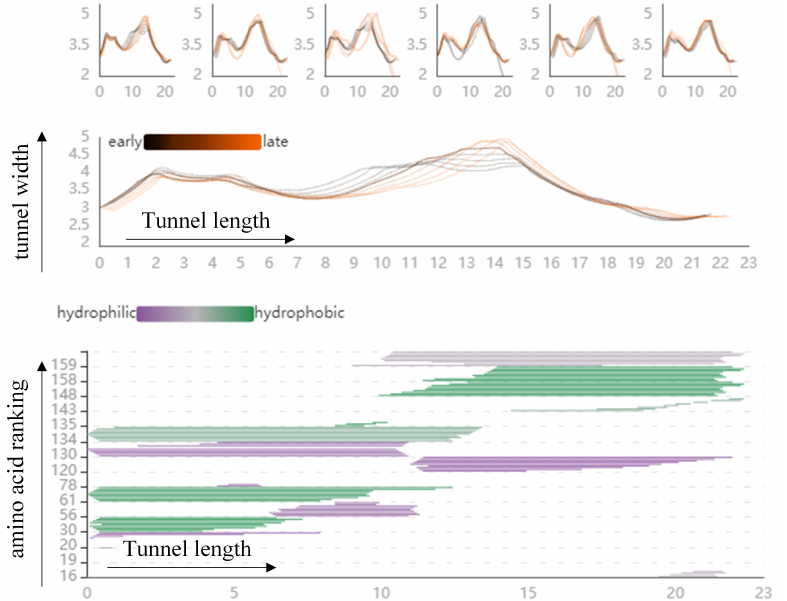
Figure 4. The PC Detail View shows the direct factors that affect the dynamic changes of the cavity. The top part shows an overview of the length and width view of the cavity in the low-frequency modes. The middle part shows the changes in cavity width along its centerline, starting from the active site on the left side, where the black line represents the early state of the cavity and the orange line the late state of the cavity. The bottom part represents all amino acids surrounding the cavity at a particular centerline location in molecular